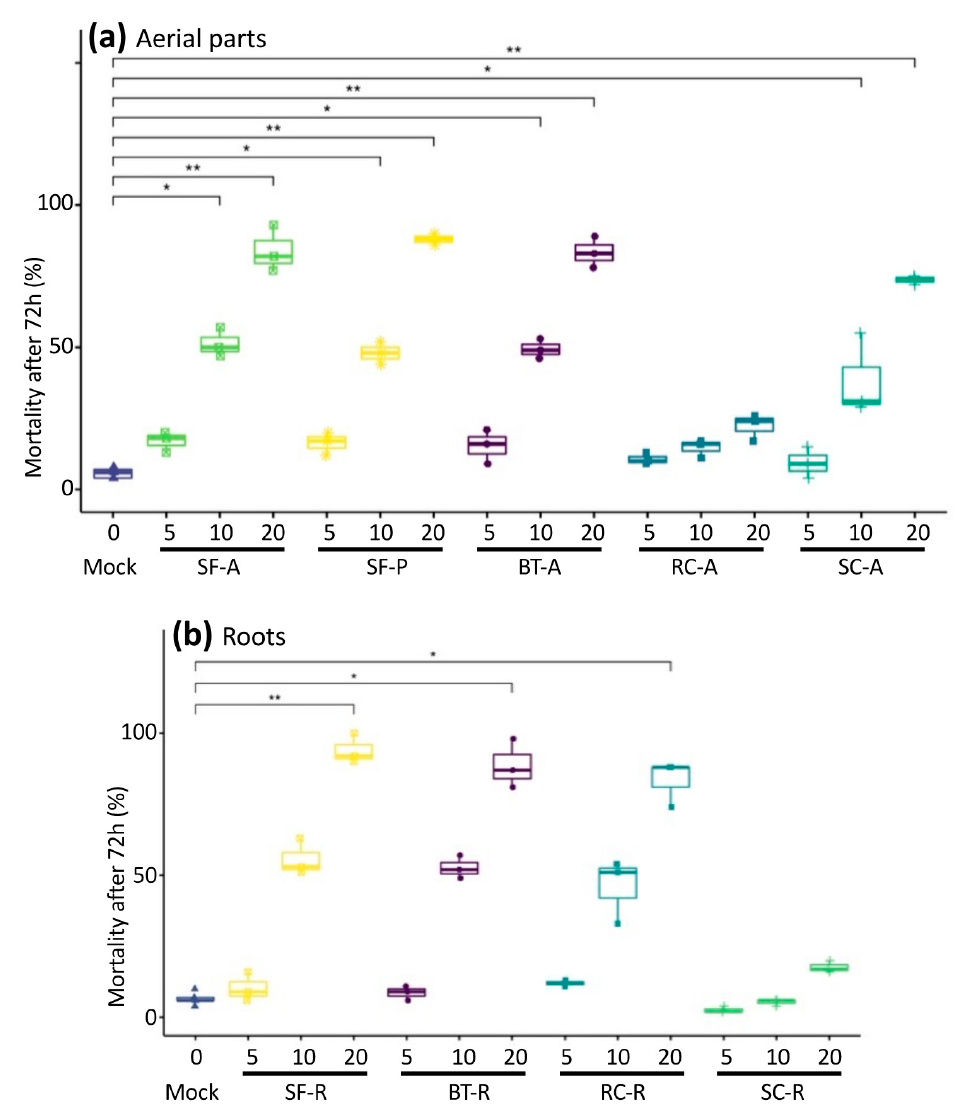
Figure 1. In vitro antagonistic effect of Fabaceae extracts on X. index . Nematodes were exposed to control conditions (1% PBS = Mock) or to the indicated Fabaceae extracts at 5, 10 and 20 g · L − 1 for 72 h. ( a ) Aerial parts extracts; ( b ) Root extracts. Impact of Fabaceae extracts on X. index was assessed by measuring mortality rate in %. Three independent repetitions of the experiment were performed with n = 50 X. index for each condition. * and ** indicate significantly different mortality compared to the Mock condition using a Dunn test, with adjusted p -value < 0.05 and <0.01, respectively.